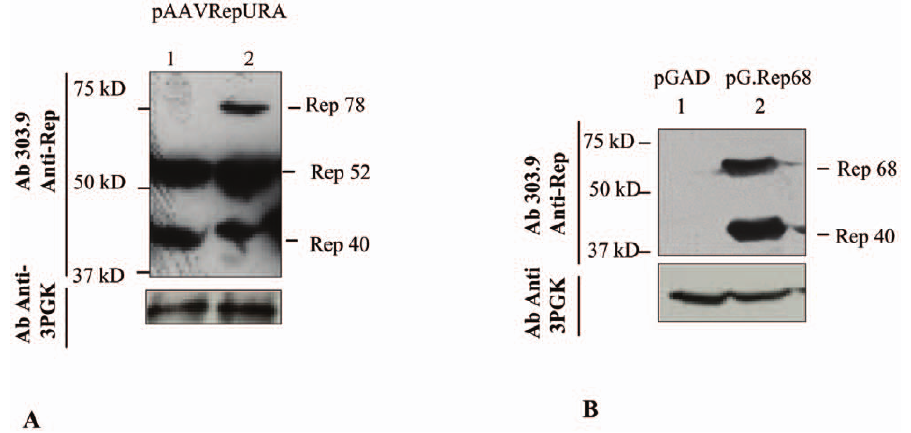
Figure 3. Rep protein expression in yeast. Western blotting of total yeast cell lysate from cells transformed with pAAVRepURA (A) and pG.Rep68 (B). (A) The two lanes were loaded with the protein obtained with first extraction (lane 1) and second extraction (lane 2). The second extraction contains Rep78, not present in the first extraction. (B) The two lanes were loaded with proteins from the second extraction of a yeast clone obtained from transformation with control plasmid pGAD (lane 1) and pG.Rep68 (lane 2). In (A) and (B), the amount of proteins loaded was detected with 3- phoshoglycerate kinase antibody (3-PGK).